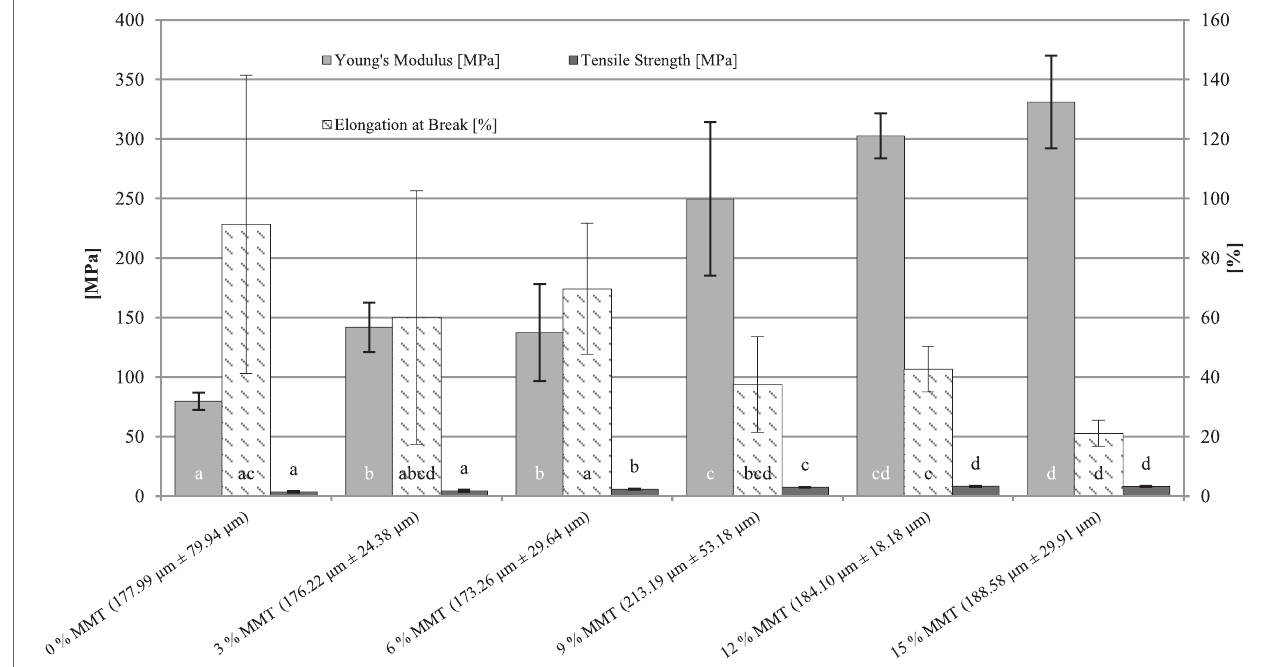
FigUre 4 | Young’s modulus, tensile strength, and elongation at break depending on different montmorillonite (MMT) nanofiller concentrations in whey protein isolate (WPI)-based [10% (w/w) WPI, 66.70% (w/w protein) glycerol] nanocomposite cast films. Film thicknesses (mean ± SD) refer to the elongation at break measurement. Different letters indicate significant differences for each sample set ( p ≤